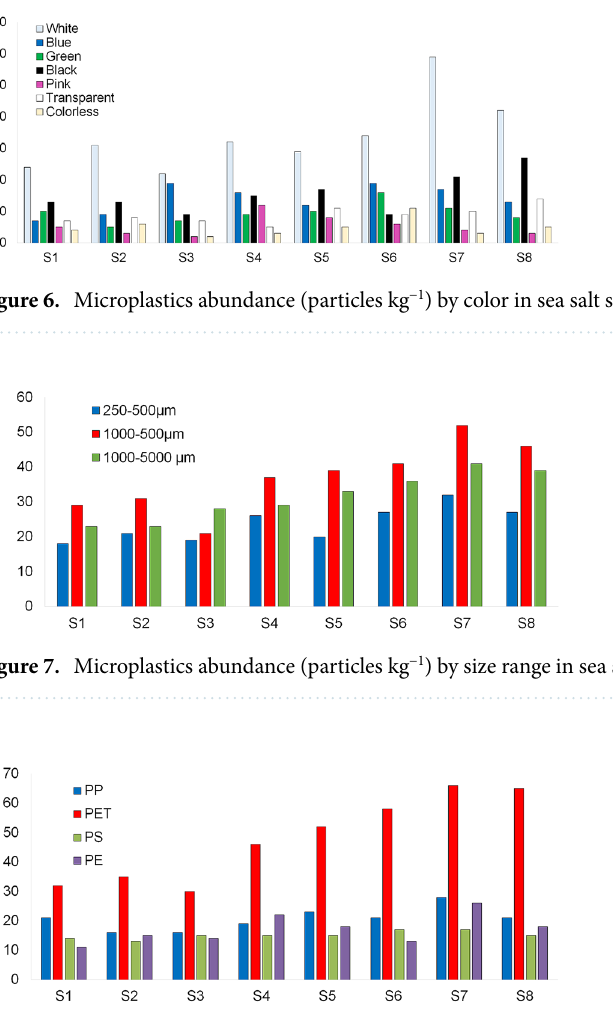
Figure 8. Microplastics abundances (particles kg −1 ) by polymer composition in sea salt samples from stations S1 to